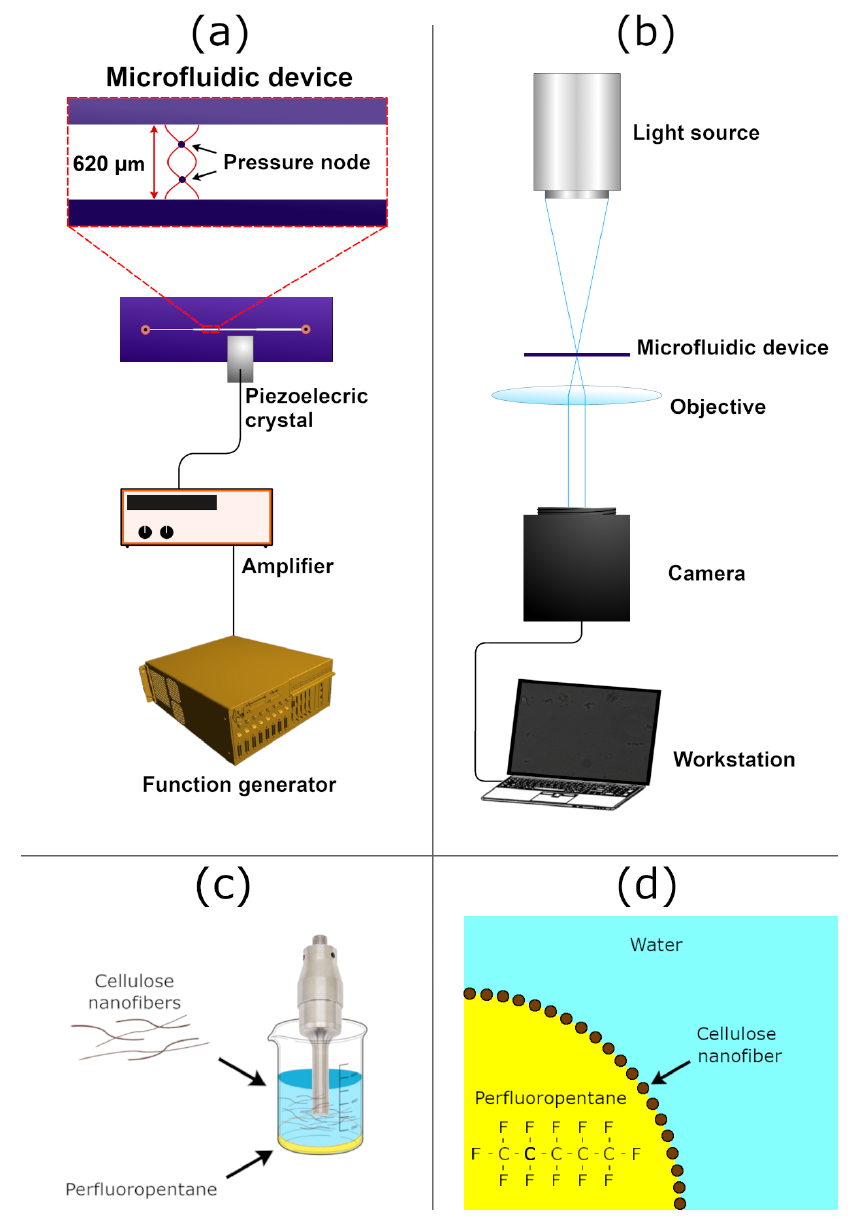
Figure 1. ( a ) The experimental setup depicting the microfluidic device used in the measurements. The piezoelectric crystal is glued to the top of the microfluidic device. The width of the microchannel is 620 µm. ( b ) The placement of the microfluidic device in the optical microscope during acoustophoresis and acoustic streaming measurements. ( c ) Simplified scheme depicting how the droplets are produced by sonication. ( d ) A simplified scheme of the droplets, where the CNFs are adsorbed at the interface between PFP and